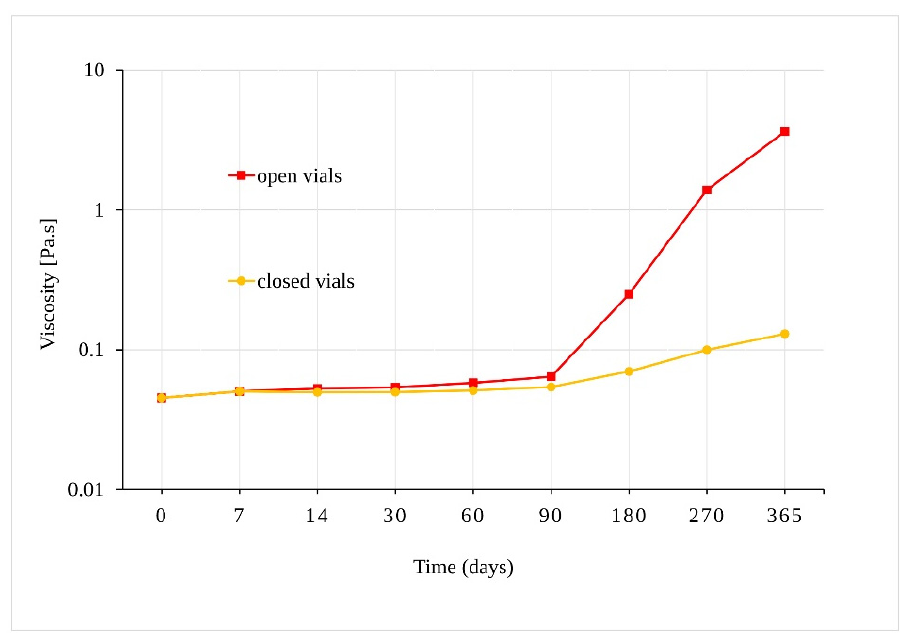
Figure 5. Dependence of the viscosity of the oil samples stored at 40 °C ± 2 °C/75% RH ± 5% in closed and open vials.